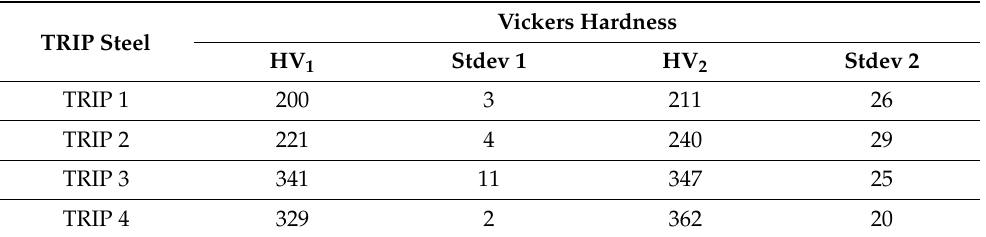
Table 7. TRIP steels’ Vickers hardness determined before and after impact bending